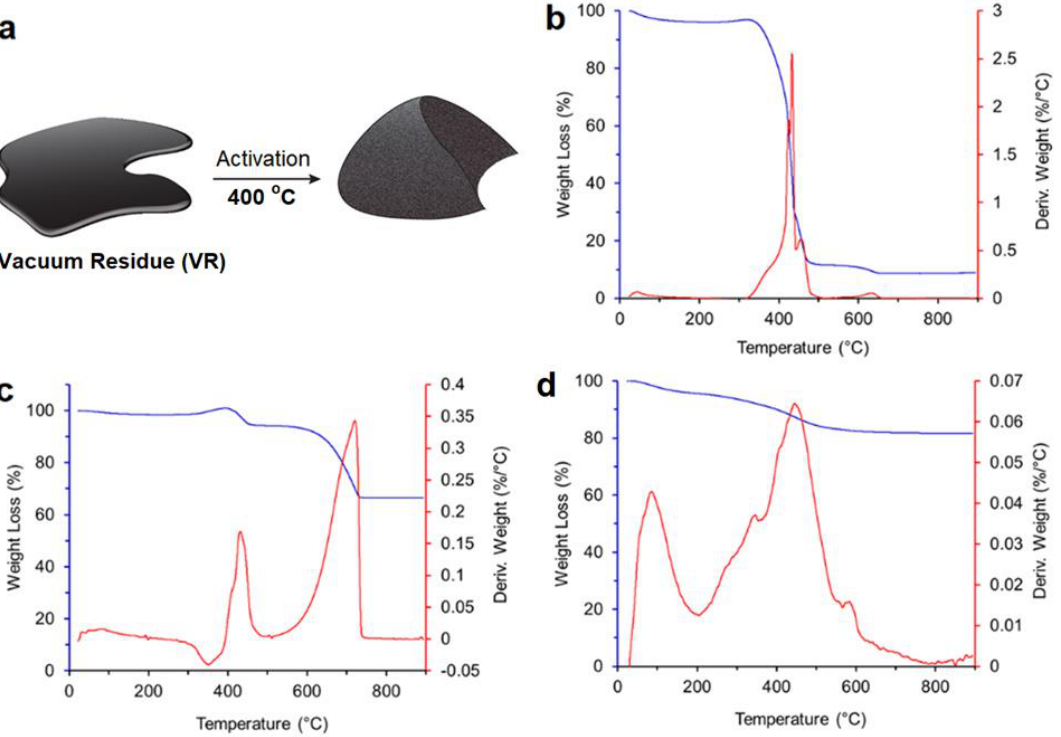
Figure 1. ( a ) Schematic representation of petroleum waste activation for porous activated carbon materials. Thermogravimetric curves of ( b ) VR-KOH, ( c ) VR-Ca(OH) 2 , and ( d ) VR-MgO (the heating rate at 10 °C min −1 , under air).